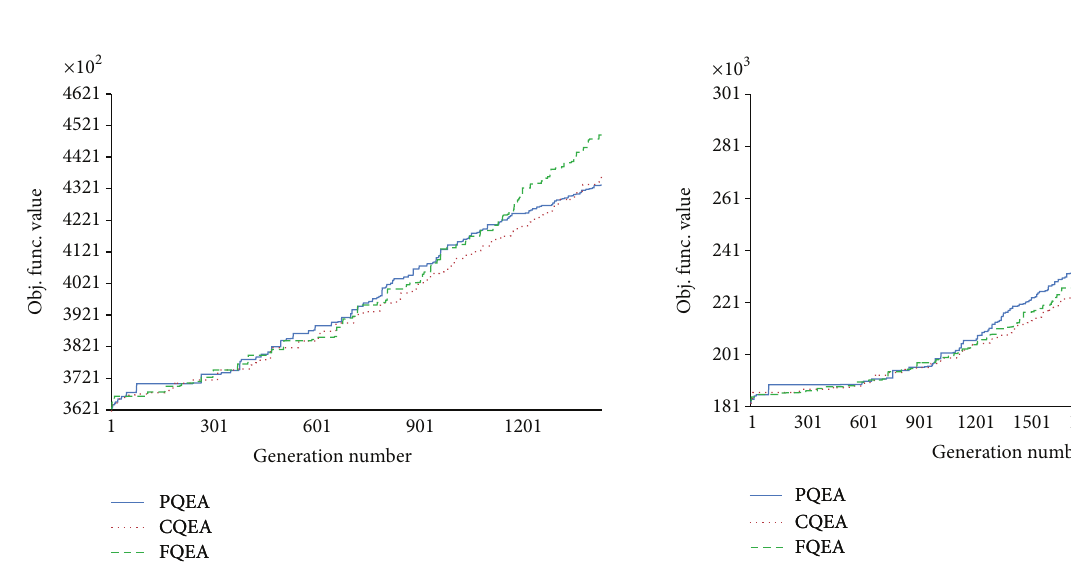
Figure 21: Convergence graph of PQEA, CQEA, and FQEA on 0-1 knapsack problem with multiple strongly correlated data instances with number of items, 𝑀 , being 200 and capacity, 𝐶 , being 5% of total weight.